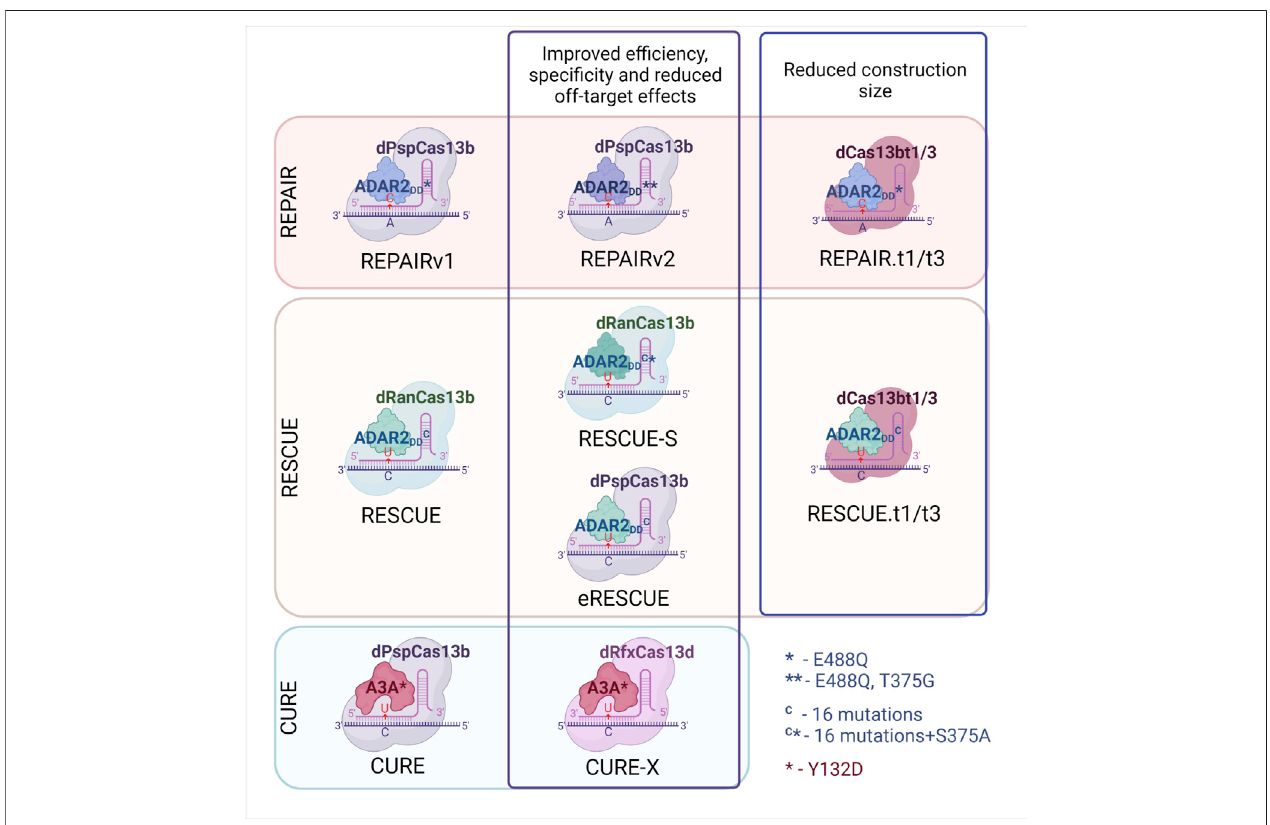
FIGURE 2| Developmentof site-directed Cas13-based RNA-editing systems. Developmentof REPAIR (A-to-I) RNA editing system, RESCUE and CURE (C-to-U) editing systems. Explanation see in the text.